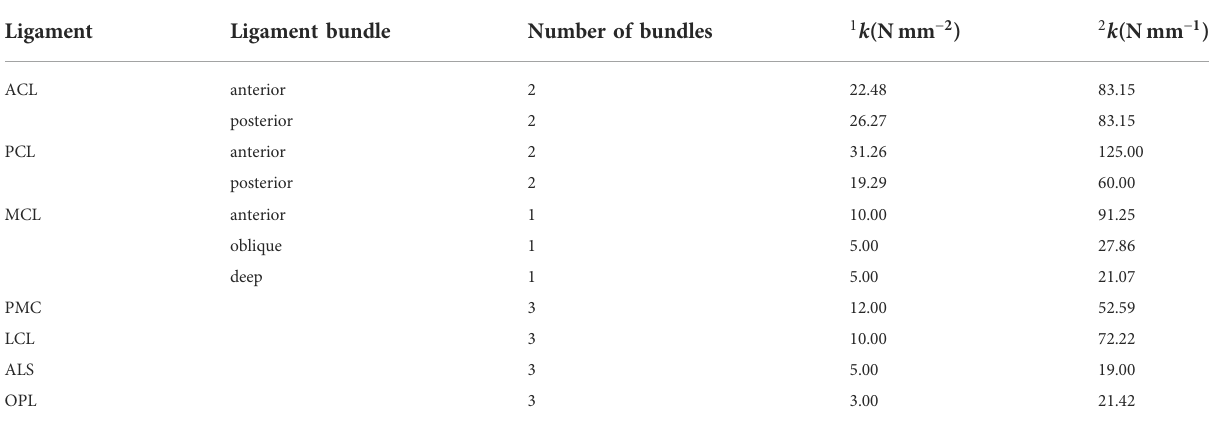
TABLE 1 Stiffness parameters of